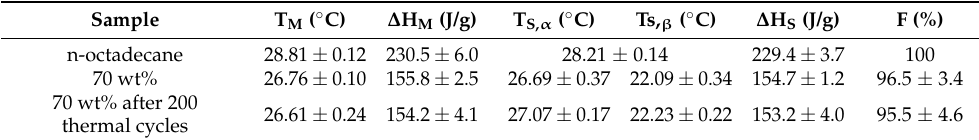
Table 1. Phase change properties of n-octadecane and the 70 wt% PCCs.